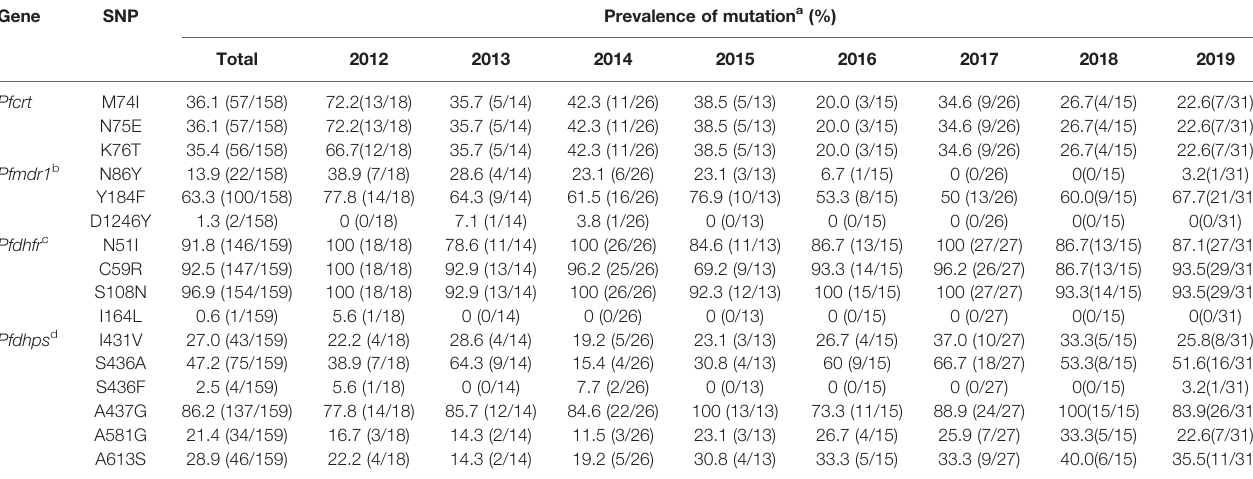
TABLE 1 | Mutant prevalence of the Pfcrt , Pfmdr1 , Pfdhfr , and Pfdhps genes detected in Plasmodium falciparum isolates returned from Nigeria during 2012 – 2019. Gene SNP Prevalence of mutation a (%)